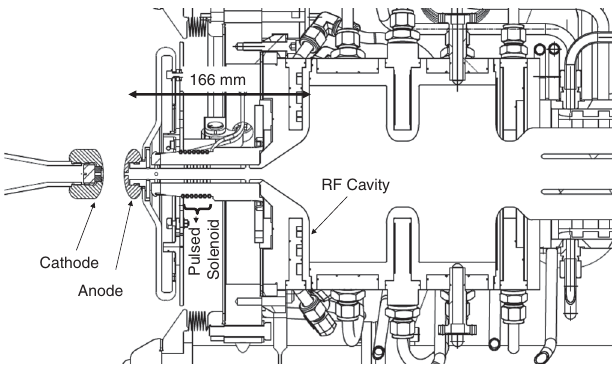
FIG. 1. Section through the diode/rf gun combination.